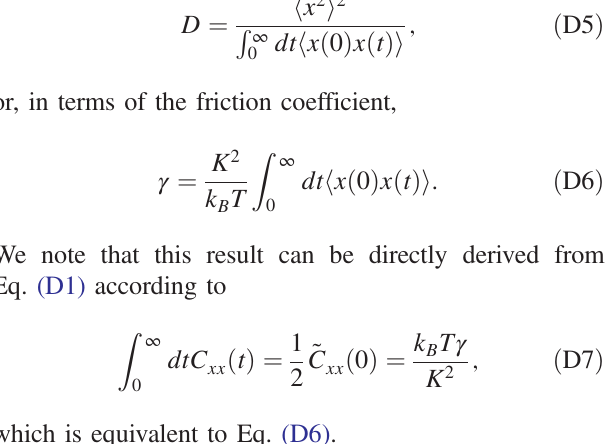
FIG. 12. Normalized position autocorrelation function C ð t Þ =C sol ð 0 Þ (red) for spring constants (a) 250 kJ = ð mol nm 2 Þ , (b) 25 000 kJ = ð mol nm 2 Þ , and (c) 250 000 kJ = ð mol nm 2 Þ C sol FF FF